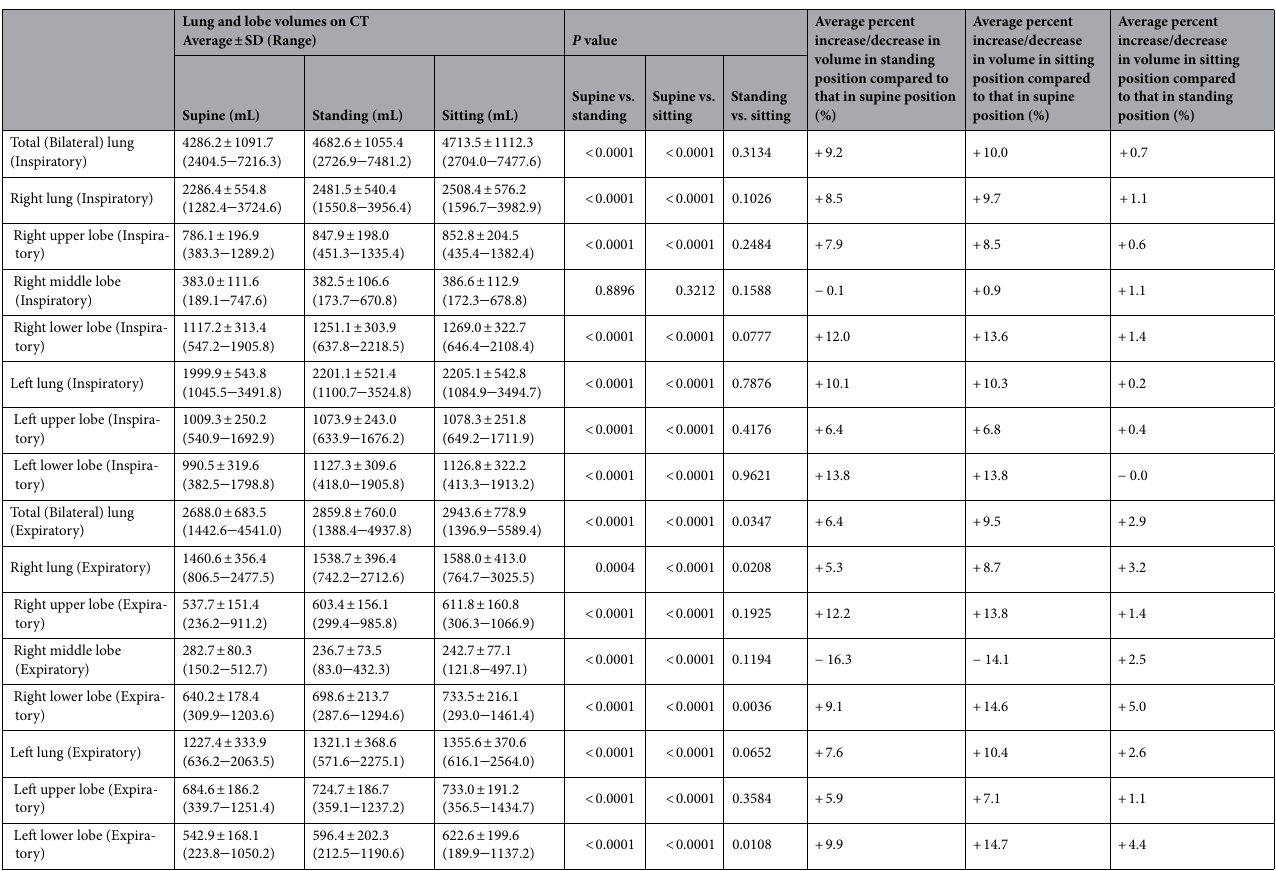
Table 2. Inspiratory and expiratory lung and lobe volumes as determined using CT in the supine position with arms raised, standing position with arms down, and sitting position with arms down (100 volunteers). P < 0.0167 was considered to be statistically significant, with Bonferroni correction for multiple